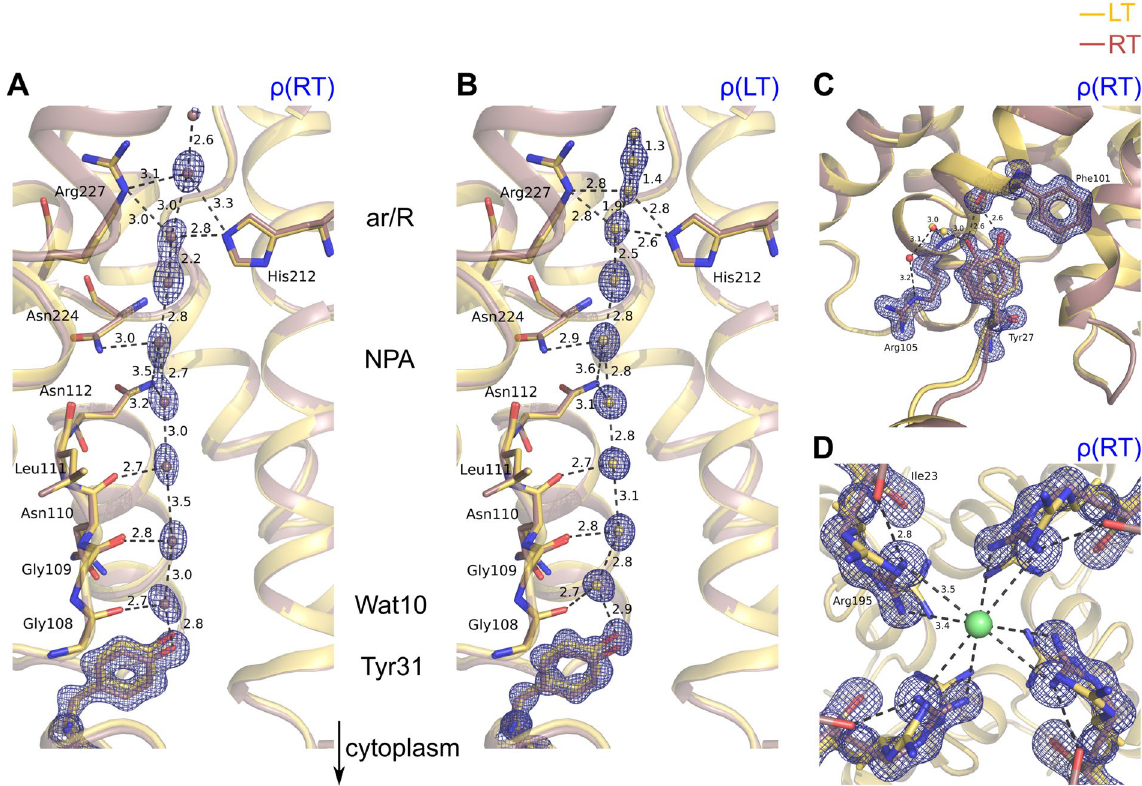
Figure 2. Electron density of Aqy1 determined by X-ray crystallography. ( A , B ) Electron density (blue mesh) of the water molecules inside the pore and of Tyr31 is shown for the RT-structure (RT, panel A) and compared to that of the LT-structure (LT, panel B). Structures have been aligned and are drawn as ribbon diagrams (RT: red and LT: yellow). Residues in direct contact with the water molecules are highlighted as sticks. The ar/R selectivity filter and the NPA constriction region are also indicated. Tyr31 is displaced further towards the cytoplasm at RT than at 100 K. The two water molecules closest to Tyr31 also move towards the cytoplasm at RT, with the water molecule closest to Tyr31 labelled Wat10. See quantitative difference in the positions of Tyr31 and the water molecules in Fig. 5A. ( C ) Tyr27, which plays a key role anchoring the N-terminus to the protein core, is observed to adopt two conformations at RT, yet only one of these conformations is occupied at 100 K. A new hydrogen bond network connecting Tyr27 to Arg105 via two water molecules is also visible at ambient temperature. ( D ) Four symmetry related Arg195-residues coordinating a single chloride ion in the central pore of the Aqy1 tetramer at room temperature. The chloride ion is located on the crystallographic 4-fold axis. In contrast, no density for the side chain of Arg195 is observed at LT (not shown). Arg195 also forms a hydrogen bond to Ile23 of the N-terminus in all protomers. In ( C and D ), the RT-electron density map is shown (blue mesh), with the structure model shown in red (RT) and yellow (LT). Interatomic distances in all panels are highlighted with the dashed lines and given in Å. All 2F obs -F calc maps shown are contoured at 1.5 σ